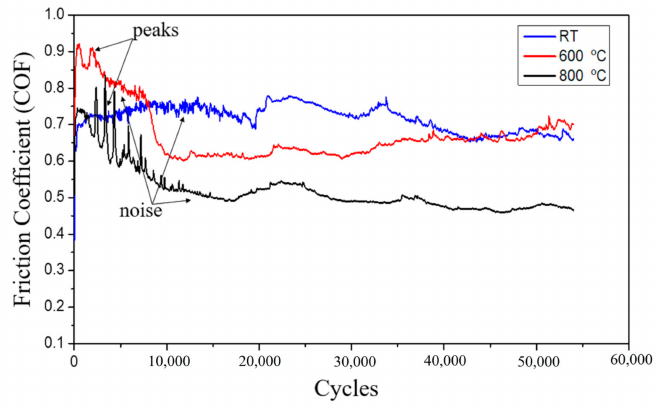
Figure 2. COF versus cycles curves taken at RT, 600 and 800 ◦